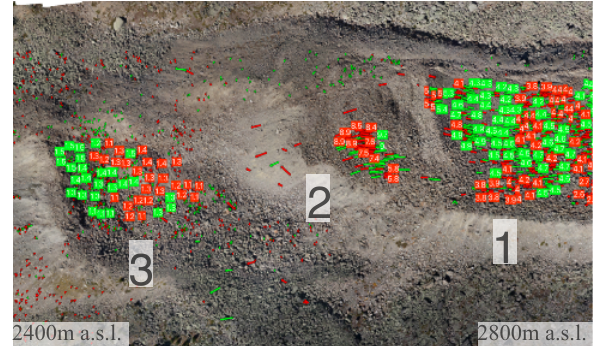
Figure 11. Tracked movement for the test site green: 2016-2017 red: 2017-2018 coloured values represent